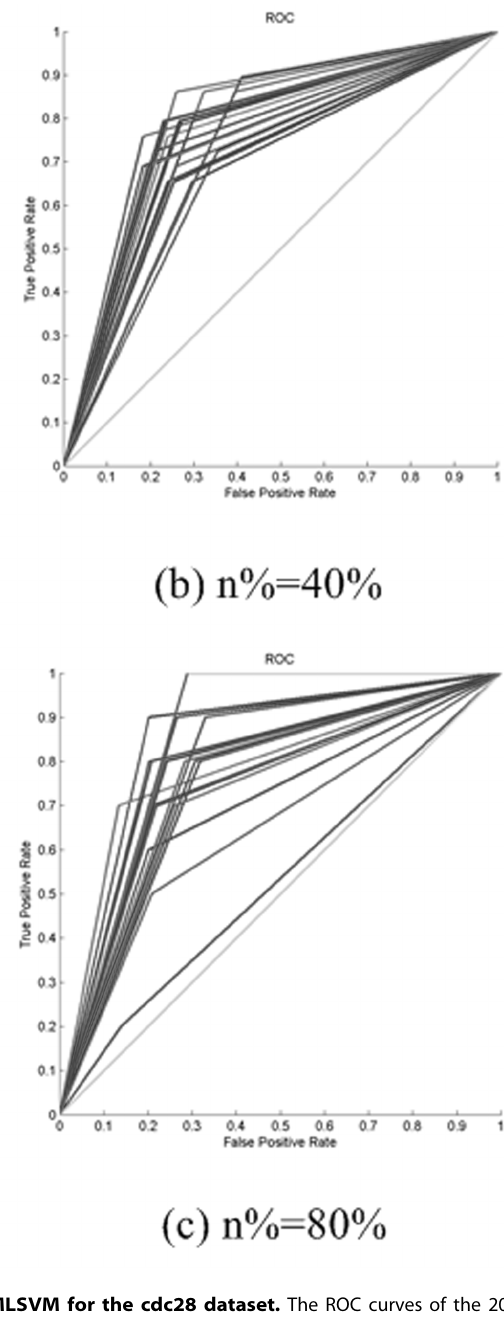
Where corr ( gene i , gene j ) is the Pearson correlation of gene i and gene j . Figure 3 shows the MIHC algorithm and flow chart of function prediction.